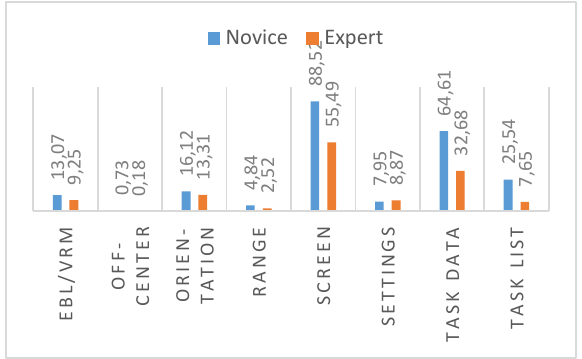
Figure 6. Comparison of means of total fixation duration of novice and expert participants on use of RADAR.